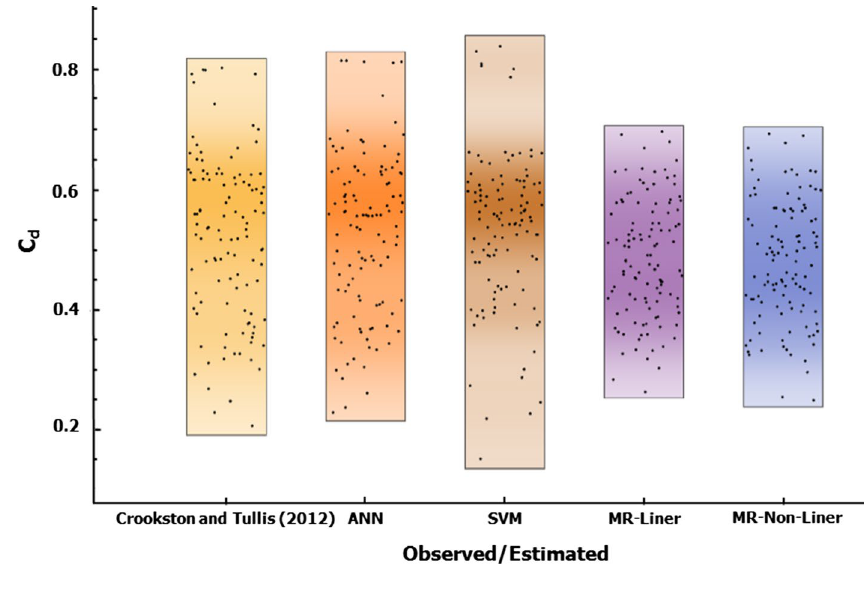
Fig. 8 Violin plot for data in the test period for observational and estimated data